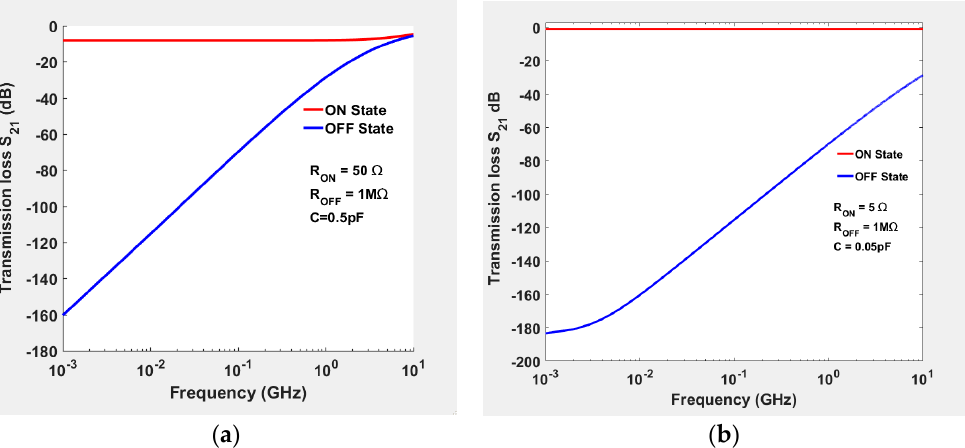
Figure 21. The transmission (insertion loss and isolation, denoted by S 21 ) characteristic of the proposed RF device; ( a )For on state resistance, R on = 50 Ω and of state capacitance, C off = 0.5 pF; ( b )For on state resistance, R on = 5 Ω and of state capacitance, C off = 0.05 pF.